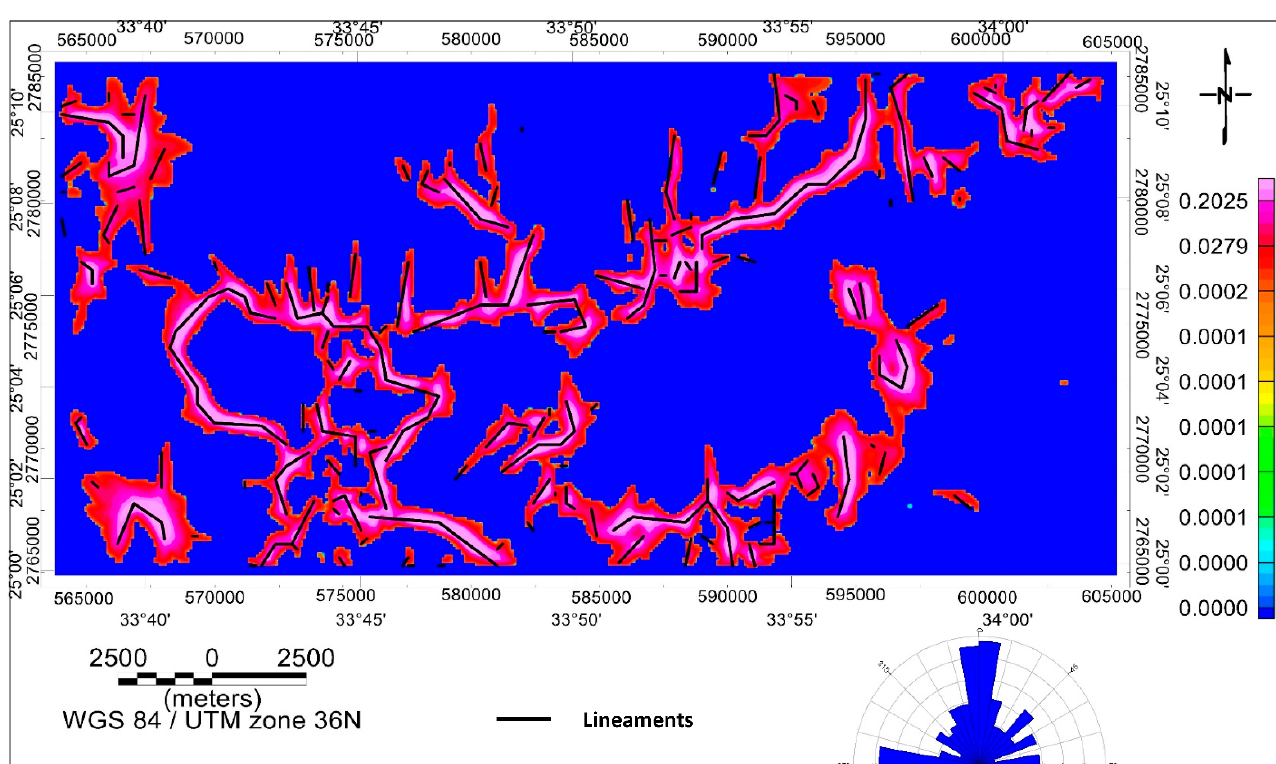
Figure 8. A map showing the research area’s TDR.